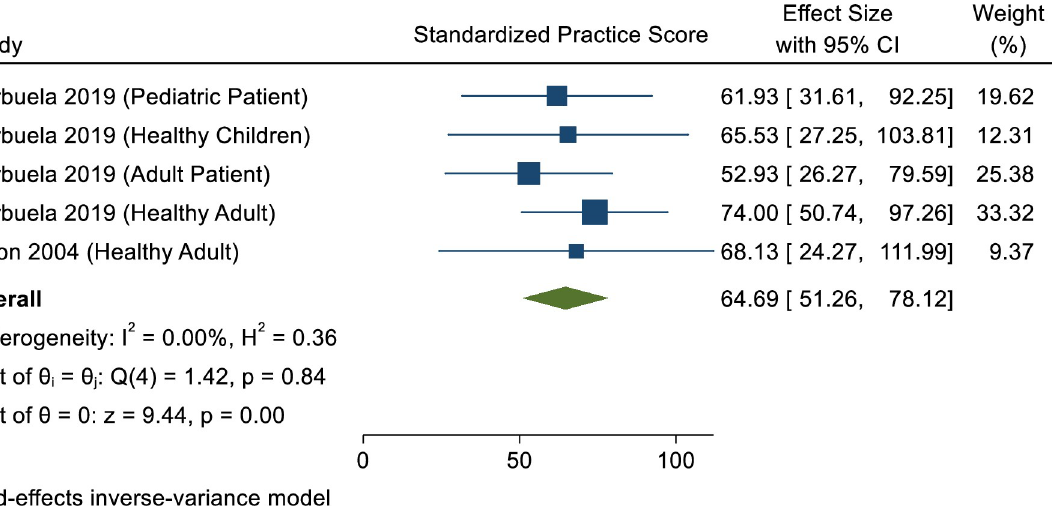
Fig 5. Meta-analysis of dengue practice score in the